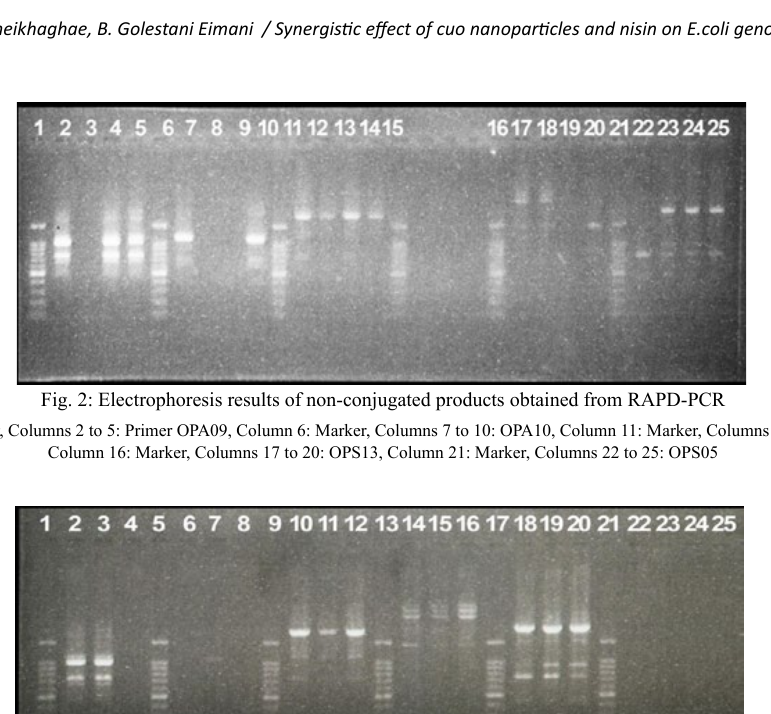
Figure 2: Electrophoresis results of non-conjugated products obtained from RAPD-PCR